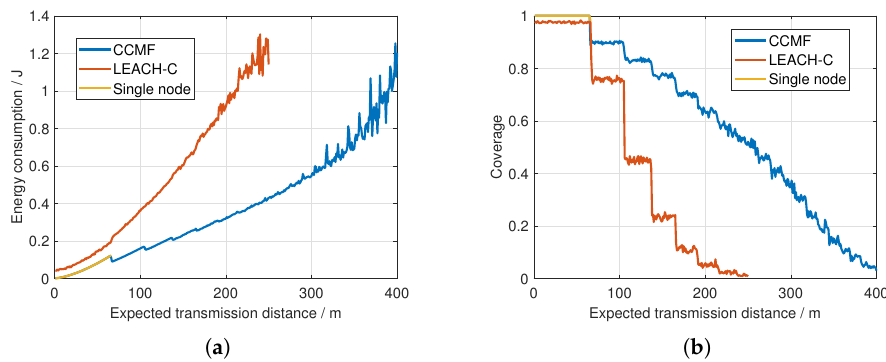
Figure 7. Perfomance comparison between CCMF algorithm, LEACH-C algorithm, and other bench- marks. ( a ) Average energy consumption per node versus expected transmission distance. ( b ) The coverage versus expected transmission distance.